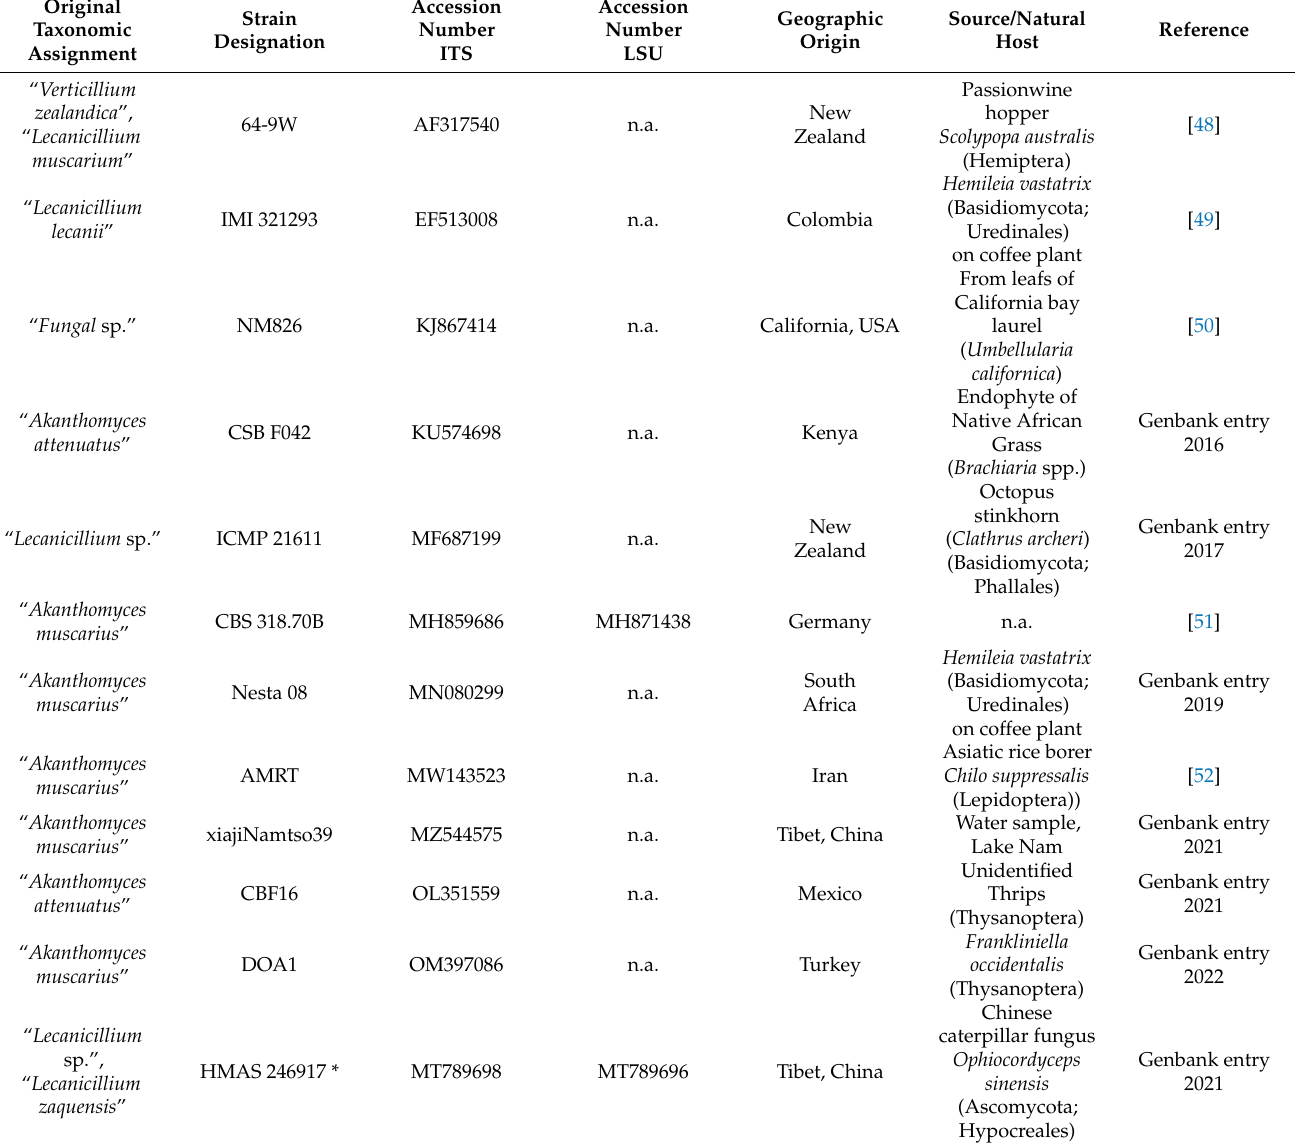
Table 2. Cryptic Lecanicillium uredinophilum/Akanthomyces uredinophilus associated Genbank